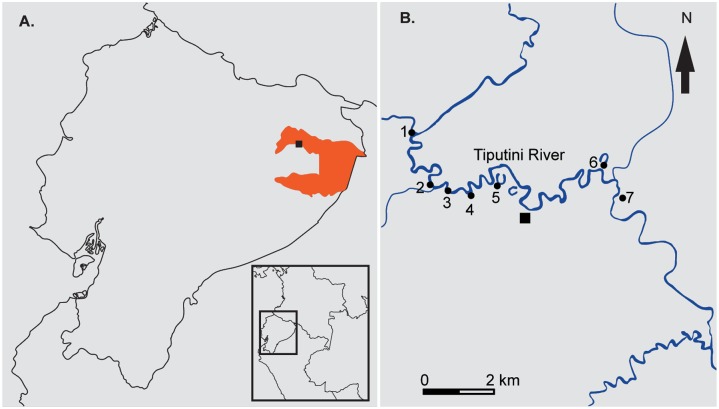
Locality.Map showing the sampled sites at Yasuní National Park. (A) Ecuador showing Yasuní National Park (in orange); (B) the sampling sites in the Tiputini River Basin and Capirón River. Legend: (1) Capirón River, (2–4) Tiputini banks, (5–6) oxbow lakes, (7) black water stream.